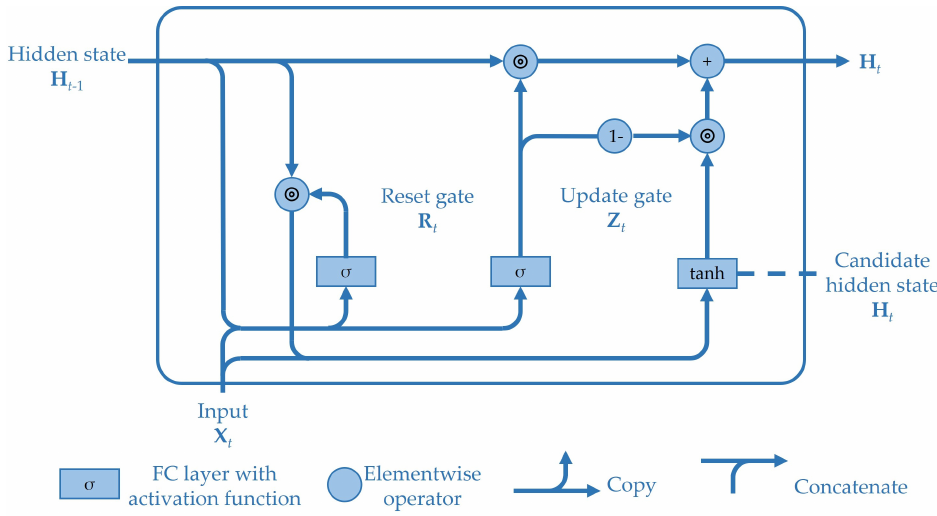
Figure 9. Gated Recurrent Unit (GRU)